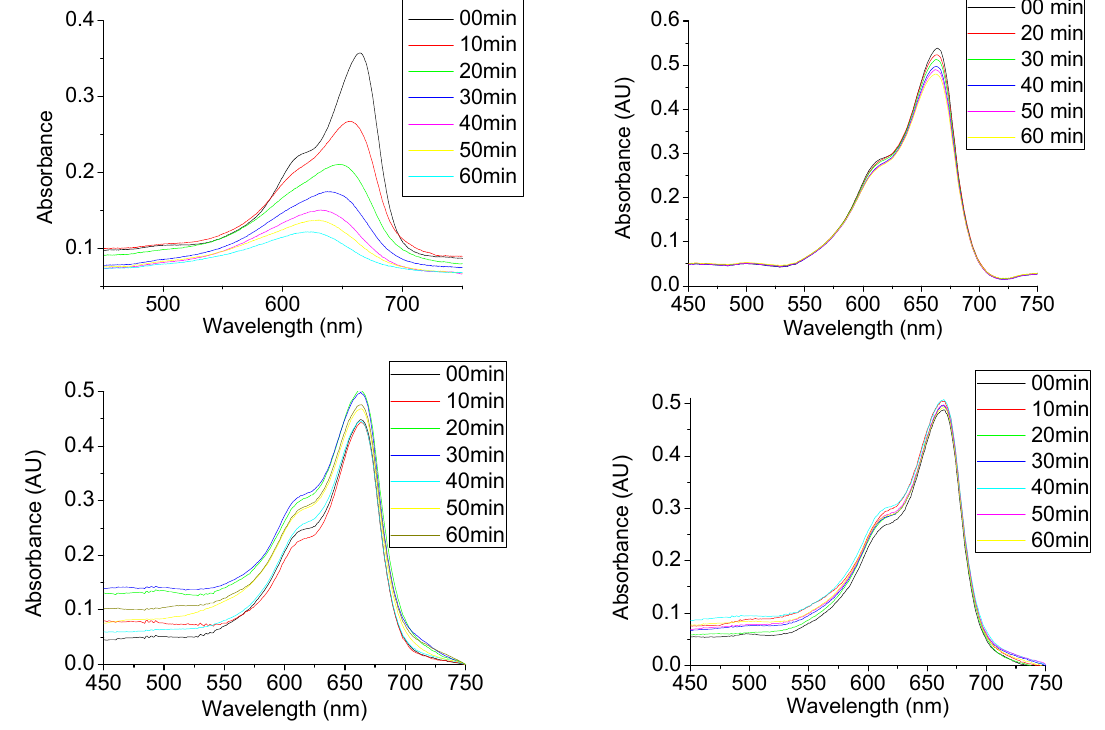
Figure 11 (Left) shows the changes in the maximum of dye absorbance plotted against time for the reaction of the CoFe 2 O 4 @SiO 2 @TiO 2 catalyst sintered at 600 °C. In the control tests it is observed